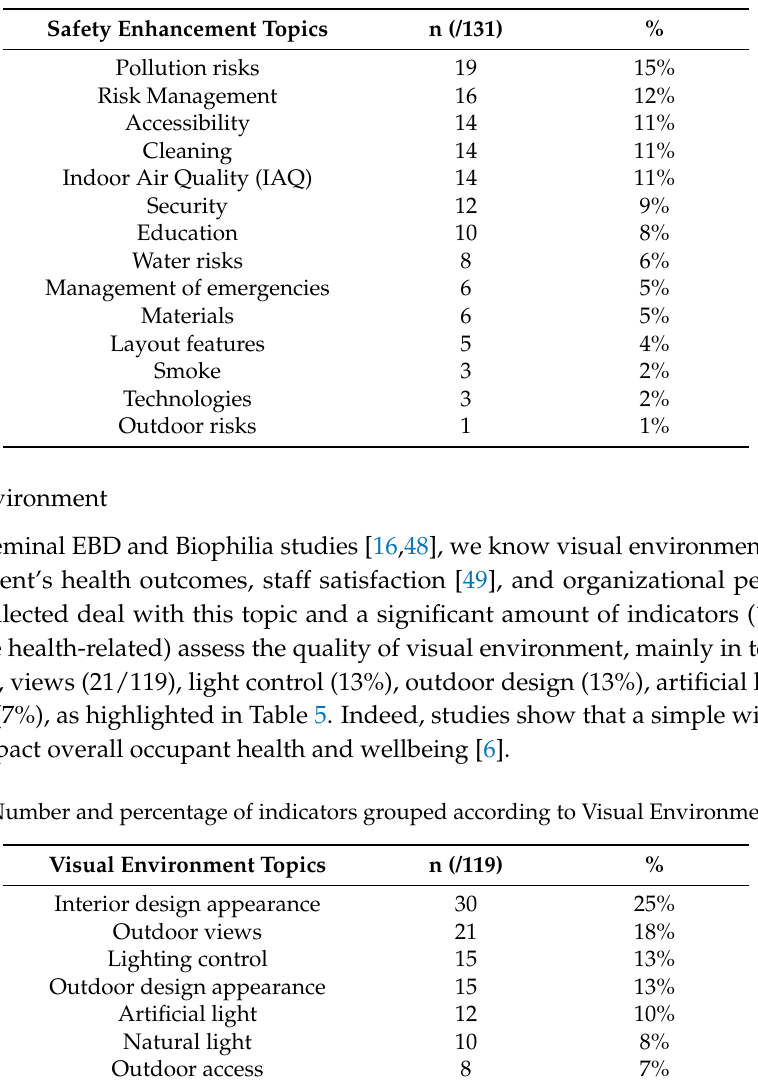
Table 4. Number and percentage of indicators grouped according to Safety enhancement topics.